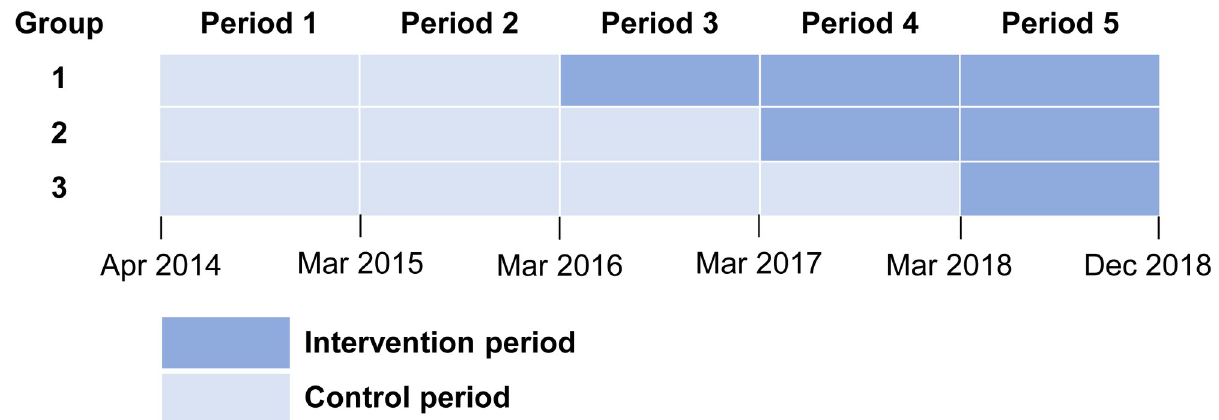
Fig 2. Schematic of the PREMEL stepped-wedge cluster-randomised controlled trial. PREMEL = multifaceted PREvention programme of MELioidosis in diabetics. No group received the intervention at baseline. Period 1 was the enrollment period, and period 2 was the baseline period. Clusters were randomly assigned to three groups that crossover to receive the intervention in March 2016, 2017 and 2018. Participants (diabetic patients enrolled) in each cluster group received a multi-faceted prevention programme once from March to July 2016, 2017 and 2018, respectively.